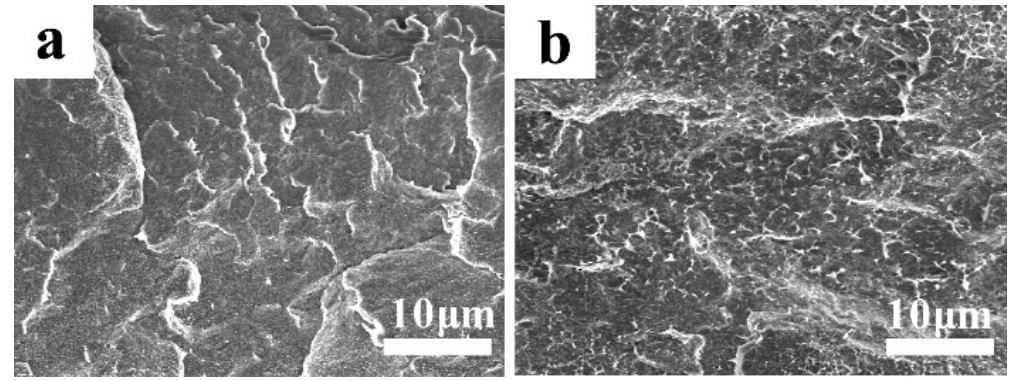
Figure 2. Cross-section morphology of a pristine PVDF membrane ( a ) and composite PVDF membrane with 0.15 wt % of graphene ( b ).